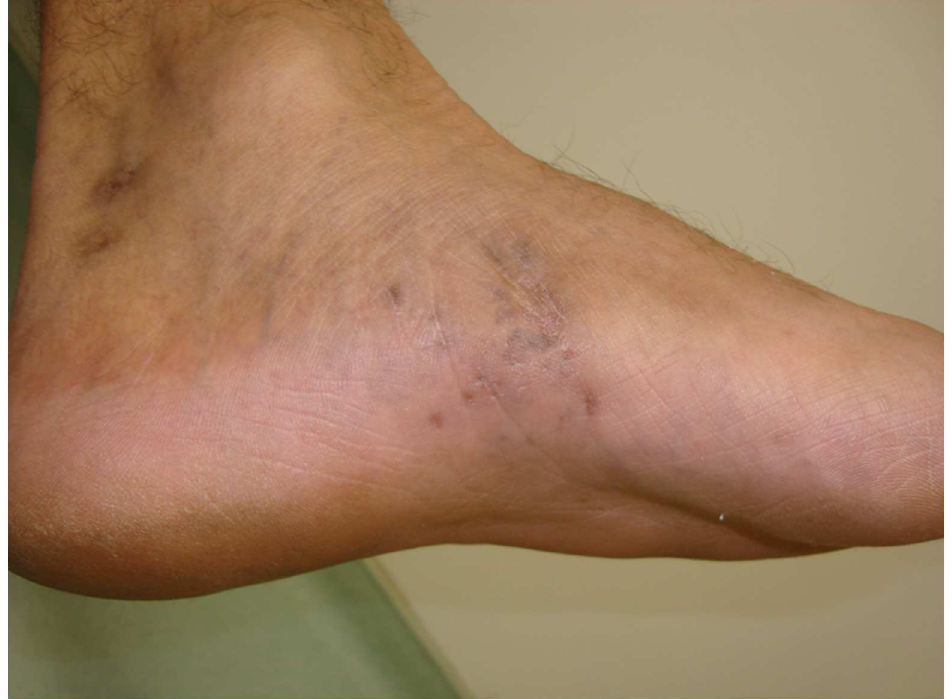
Fig 2. HIV patient with actinomycetoma after treatment.